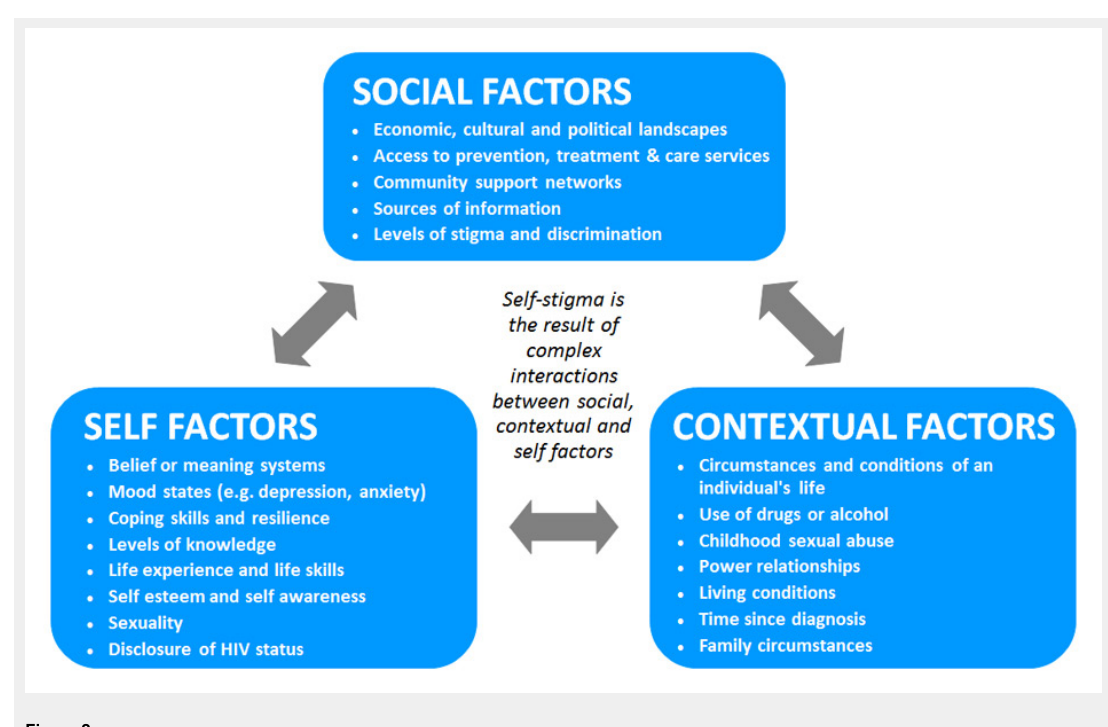
Figure 2 Conceptual framework of self-stigma. Designed using concepts from Morrison (2006) [52], the framework comprises three interacting groups of factors (factors listed are non- exhaustive) which influence self-stigma: social factors, contextual factors and self factors. The complex interaction between these factors influences the development and perpetuation of